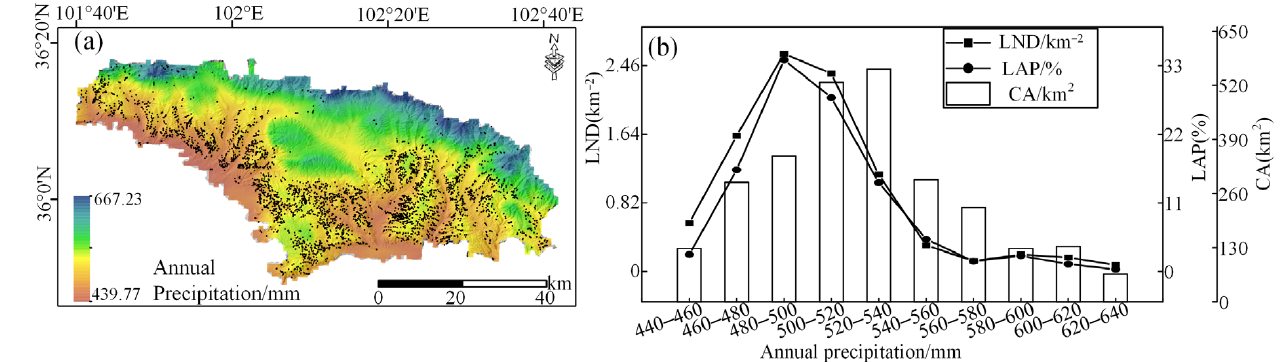
Figure 14. Relationship between average precipitation and landslide distribution. ( a ) Average precipitation distribution in the study area. ( b ) Statistics of landslide indicators in the average precipitation intervals.